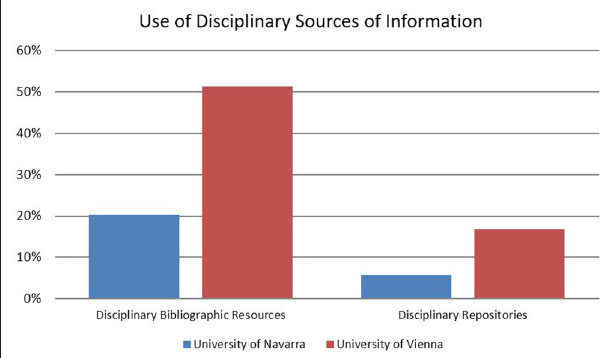
FIGURE 1 | Use of disciplinary sources of